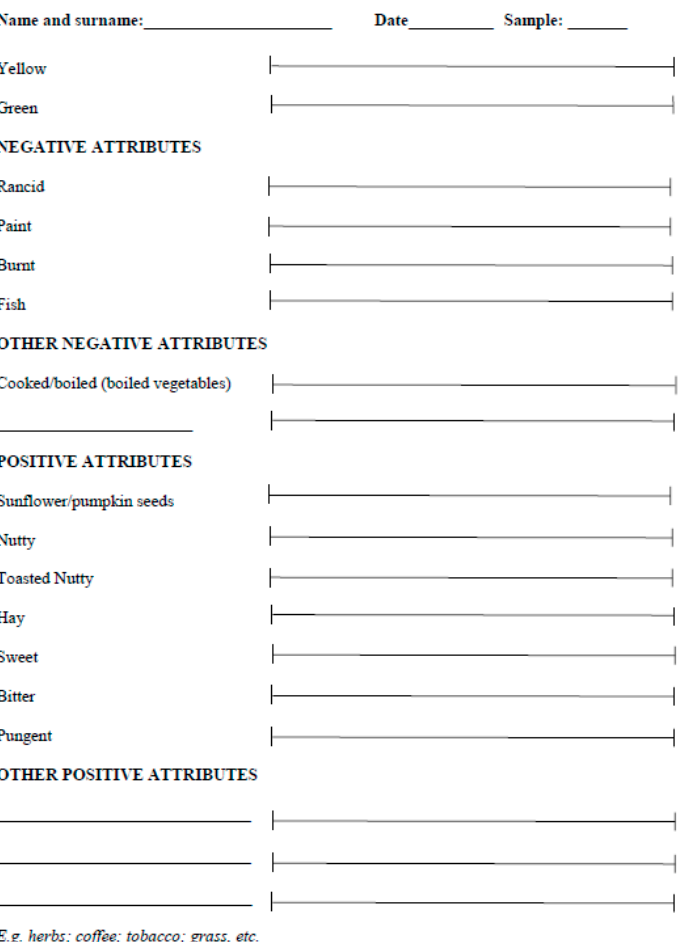
Figure 1. Sensory profile sheet specifically developed for cold-pressed hemp seed oils. The intensity of each attribute is evaluated with the use of a 100 mm unstructured scale with two anchor points: 0 (not perceivable) and 100 (extremely